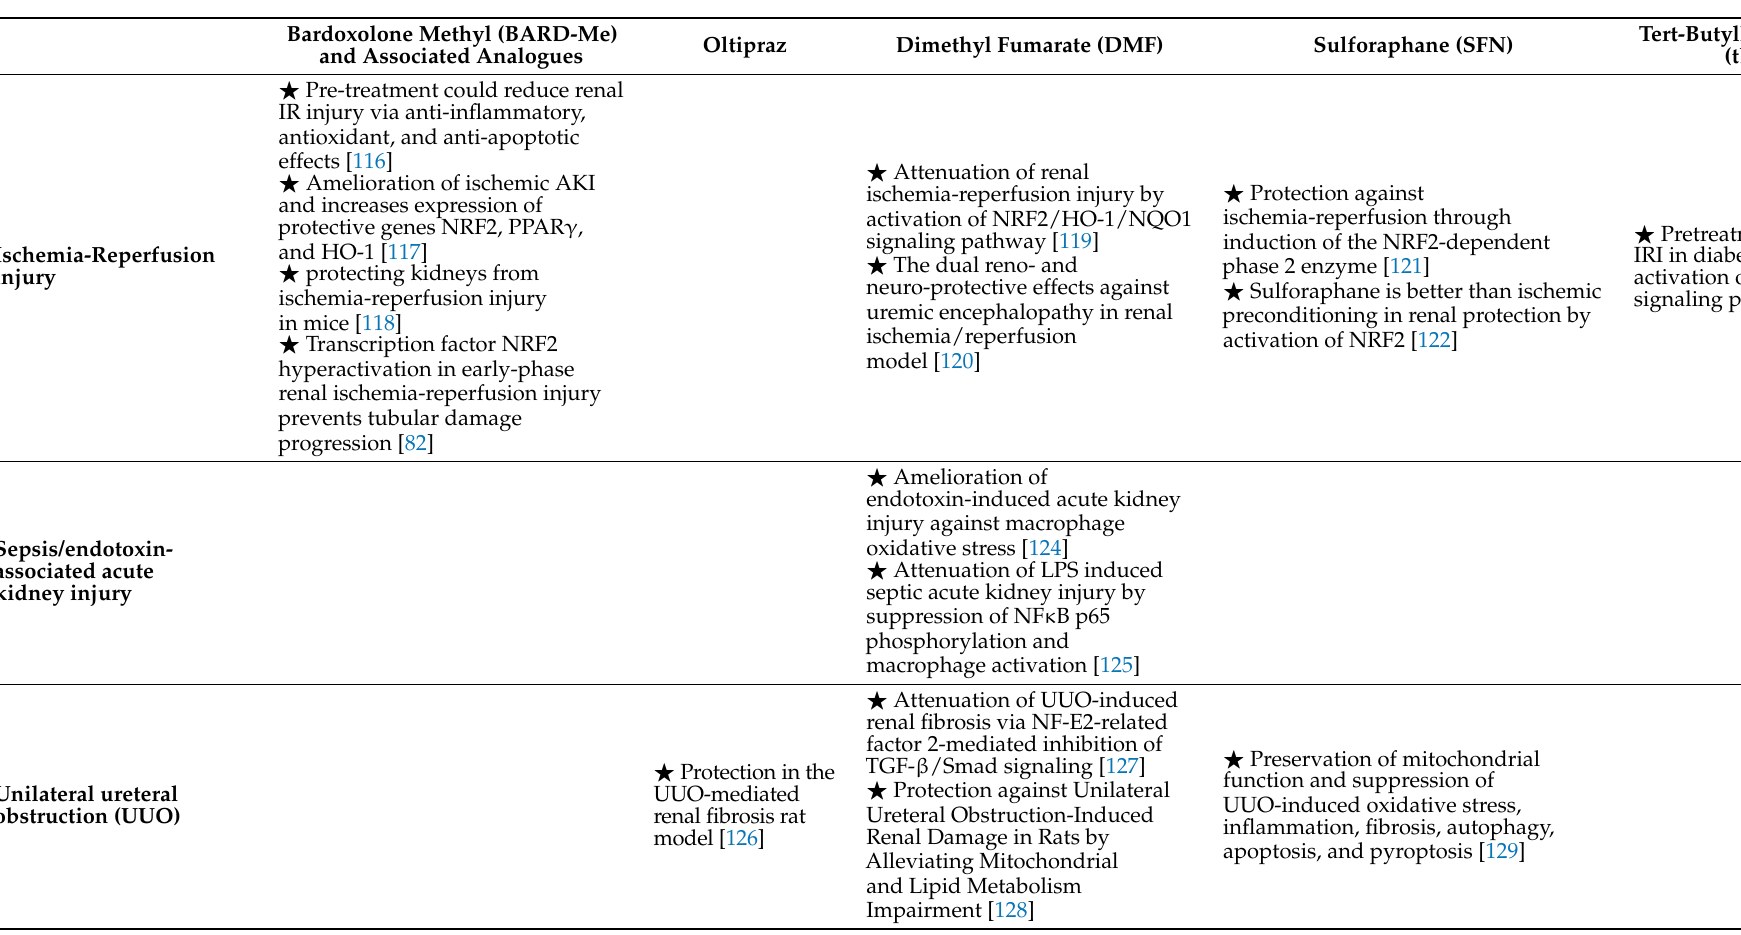
Table 1. Application of NRF2 modulator in vivo studies and clinical trials of kidney